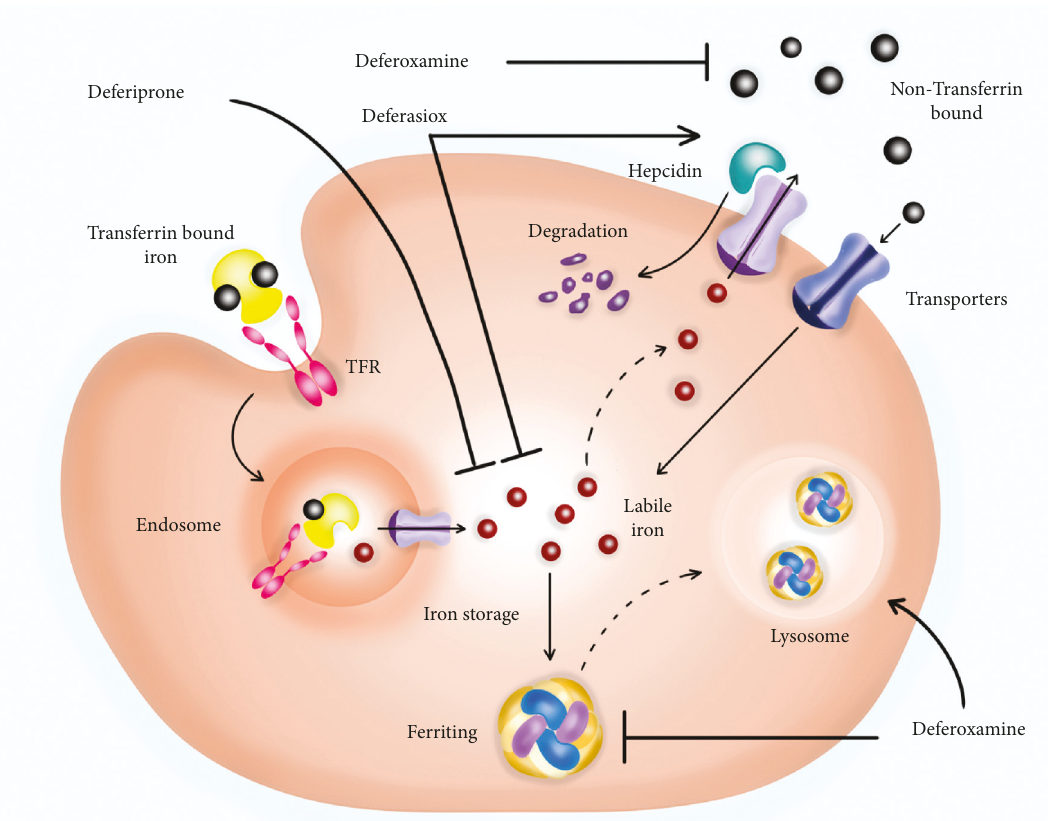
Figure 1: Deferoxamine, deferiprone, and deferasirox mechanism of action in the management of iron overload. Deferoxamine binds to nontransferrin bound iron or to iron found in ferritin forming a molecule which is later excreted via the kidneys. Deferoxamine also promotes ferritin degradation in lysosomes. Deferiprone and deferasirox chelate cytosolic labile iron. Besides, deferasirox can increase the levels of hepcidin that results in the degradation of ferroportin. TFR, transferrin receptor.